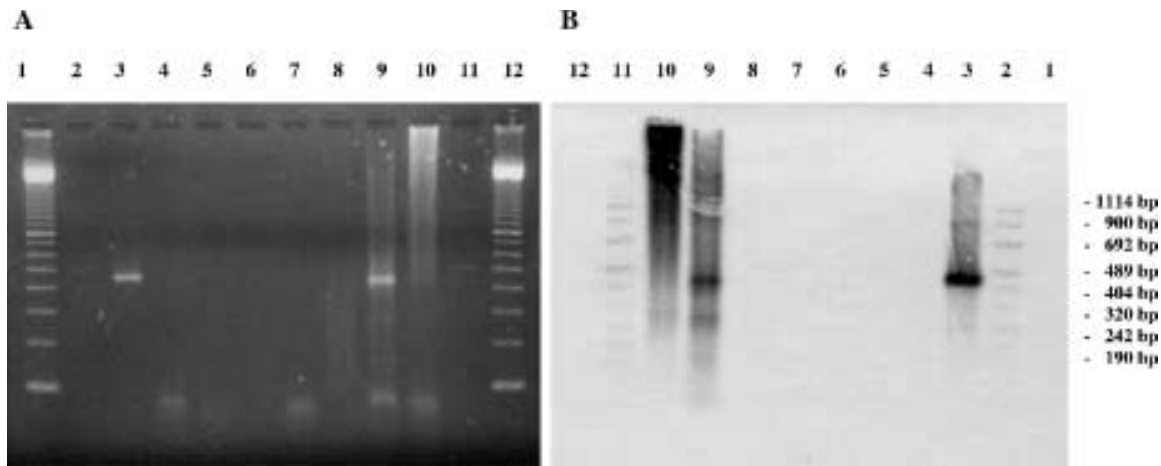
Fig. 2. PCR products obtained after solution-phase RT-nested PCR in the agarose gel electrophoresis (A) and corresponding Southern blot (B). Lanes 1 and 12, 100 bp ladders; lanes 2 and 11, DIG-labeled ladders, lengths are shown on the right side; lane 3, amplicons (447 bp) after 60 PCR cycles with an annealing temperature of 70 ◦ C; lane 4, omission of extrinsic primers in the first PCR; lane 5, omission of extrinsic primers and Taq DNA polymerase in the first PCR; lane 6, without reverse transcription; lane 7, after pretreatment of templates with RNAse; lane 8, without templates; lane 9, PCR products from lane 10 after treatment with restriction endonuclease Bsi HKA I; lane 10, high molecular weight products after 60 PCR cycles with an annealing temperature of 52 ◦